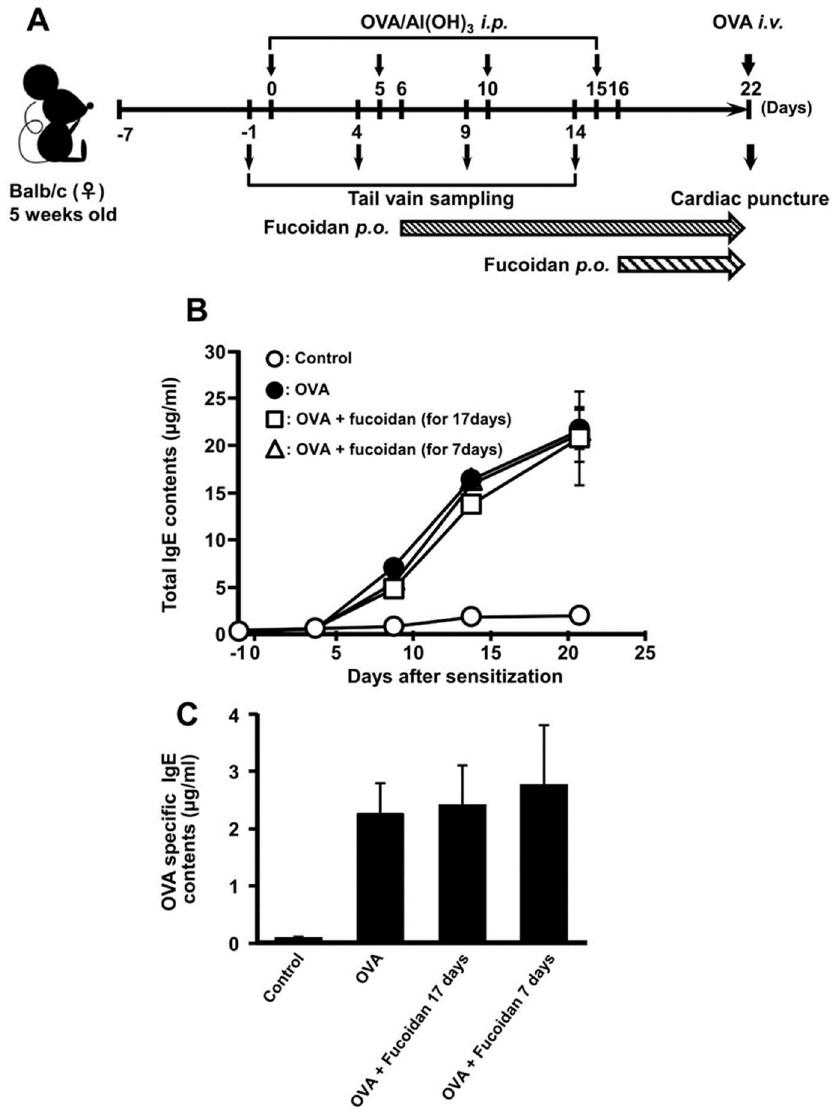
Figure 2. The effect of F-fucoidan on the increase in IgE induced by OVA injection. Mice were immunized by injection of OVA and administrated F-fucoidan orally (60 μg/mouse/day) as described in the Materials and Methods. ( A ) Schedule of OVA-induced allergy experiment. ( B ) Total IgE levels in blood collected from the vain 1 day before OVA injection were measured by ELISA. ( C ) Whole blood was collected by cardiopuncture 1 day after OVA challenge and plasma was obtained. OVA-specific IgE levels in blood plasma were measured by ELISA. Values represent means ± SEM of 4–5 mice in each group.